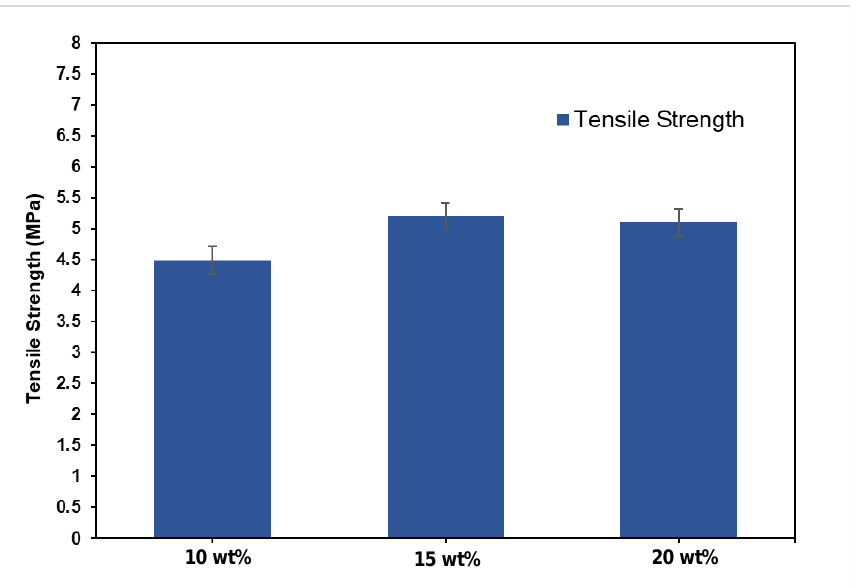
Figure 5. Graph of average tensile strength for each sample with increasing RHA composition during Brazilian Testing.